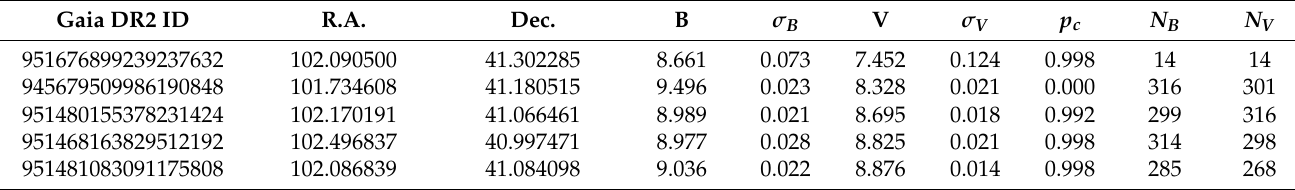
Table 1. BV photometry of the NGC 2281 field.